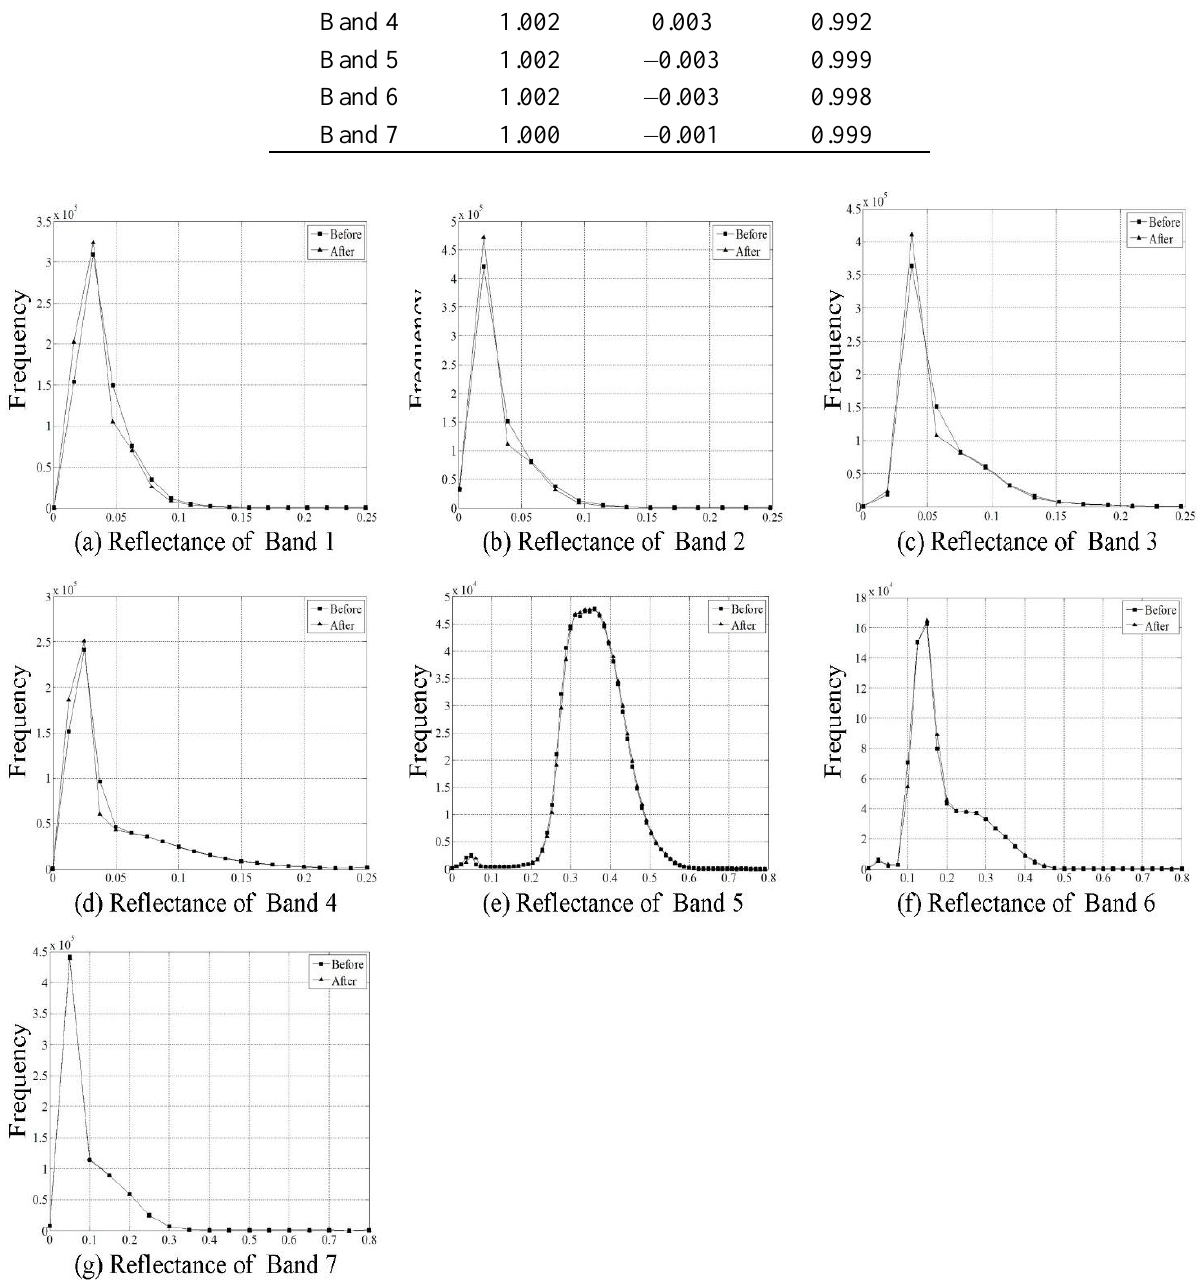
Figure 9. Histograms of reflectance values for cloud-free pixels before and after the algorithm. ( a ) Band 1; ( b ) Band 2; ( c ) Band 3; ( d ) Band 4; ( e ) Band 5; ( f ) Band 6; ( g ) Band